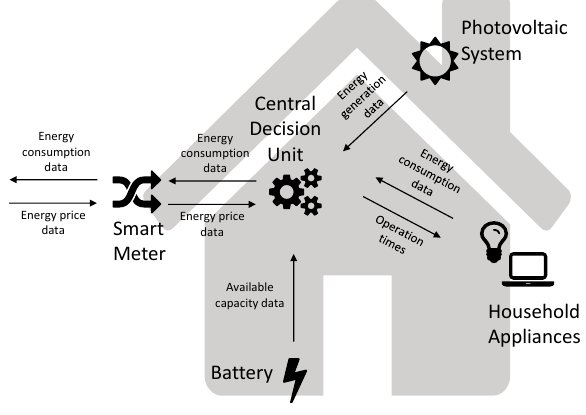
Figure 2. Simulation model.